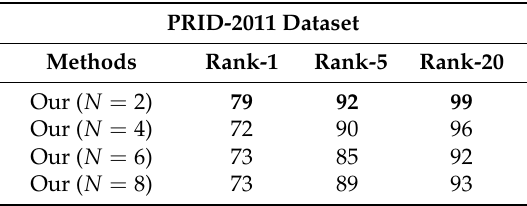
Table 6. Verification experiment results for the pivotal frame’s number for the PRID-2011 dataset in terms of CMC values.